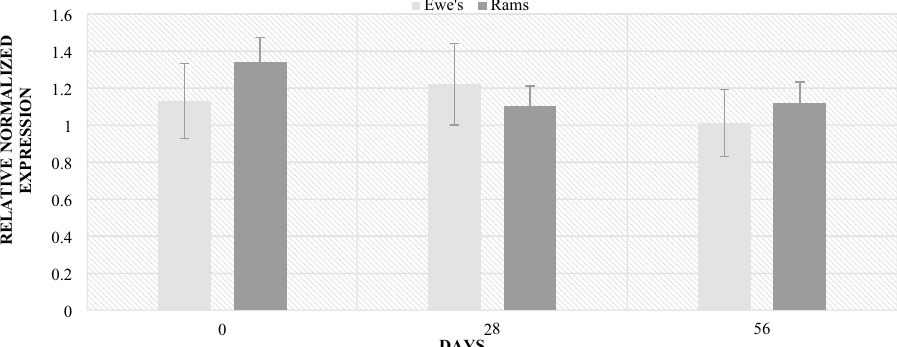
Figure 11. Level of Lactobacillaceae (RNE) depending on sex.